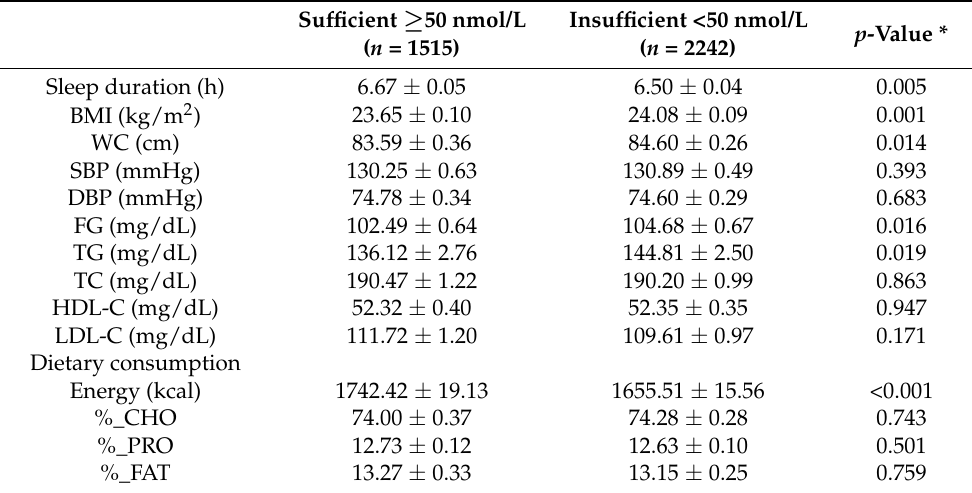
Obesity-related variables and dietary macronutrient consumption according to the 25-hydroxyvitamin D